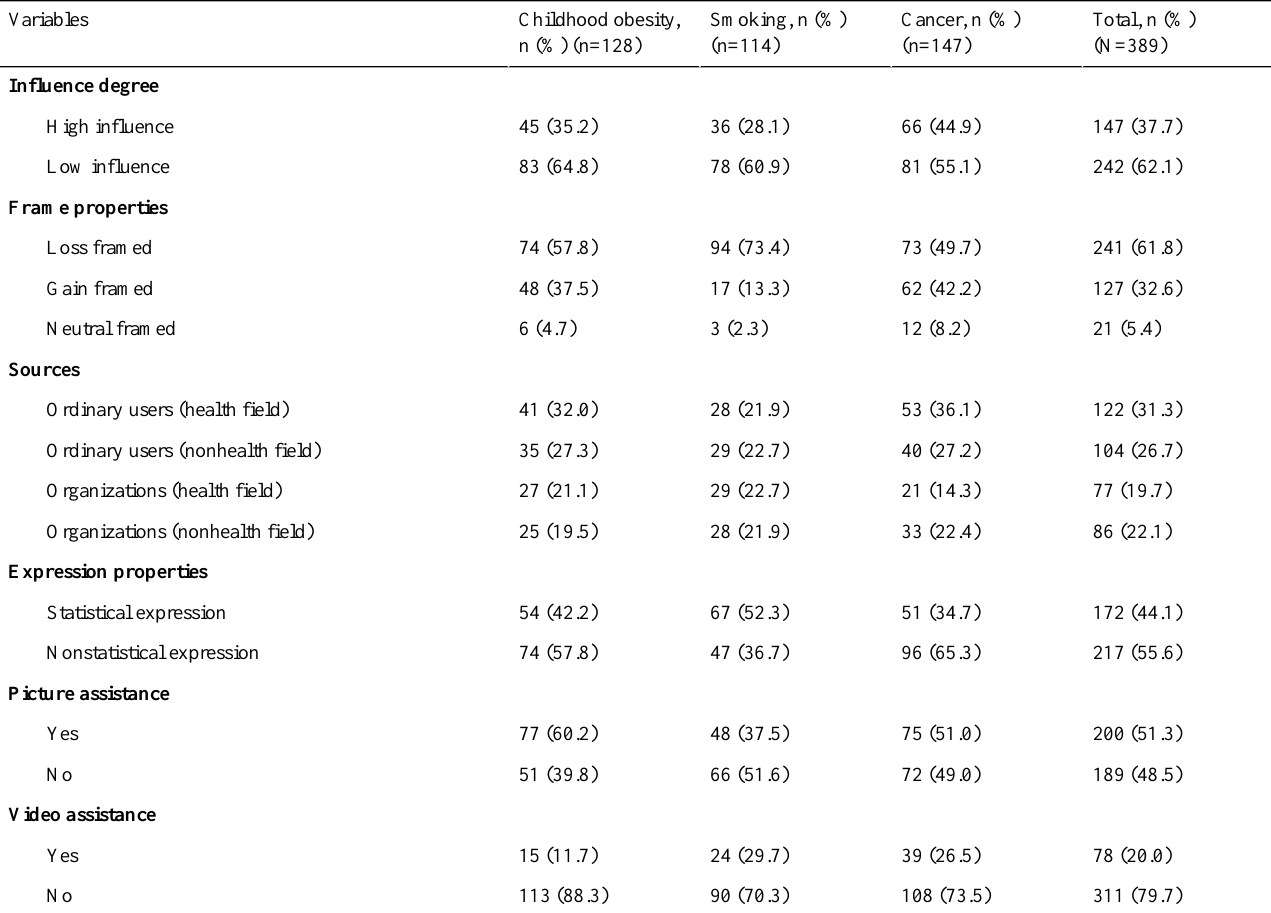
Table 1. Descriptive statistics of characteristics of health-promoting